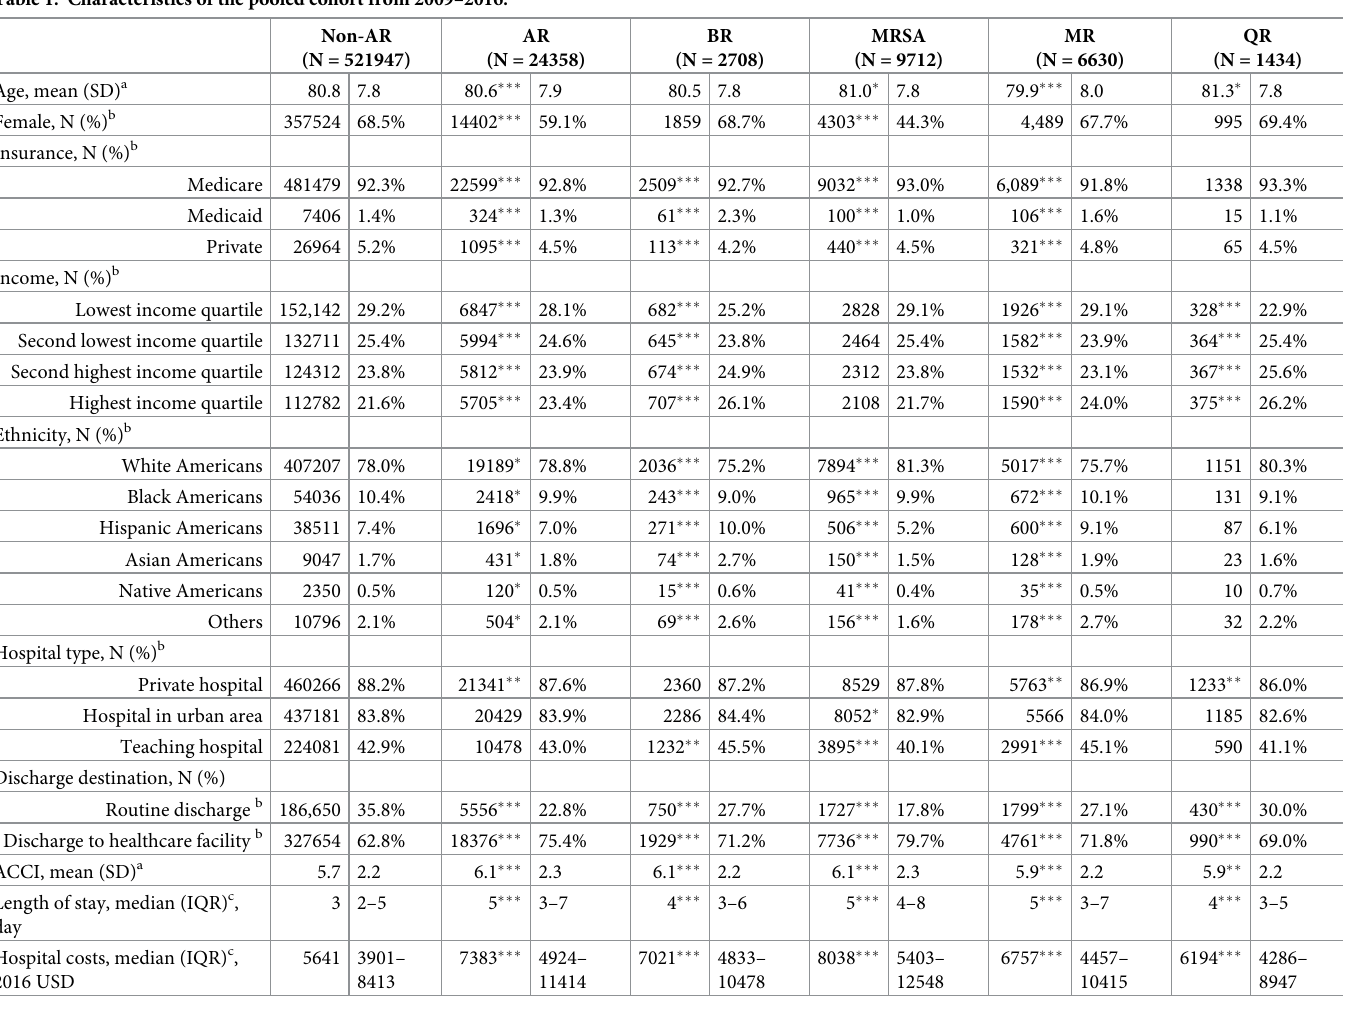
Table 1. Characteristics of the pooled cohort from